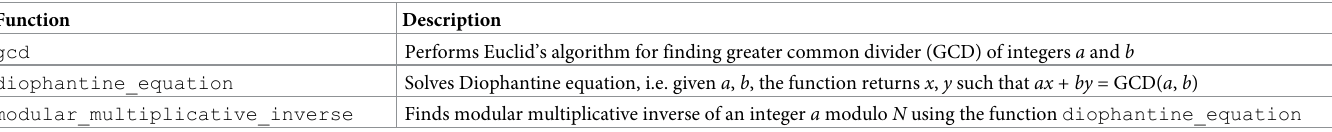
Table 2. Classical auxiliary